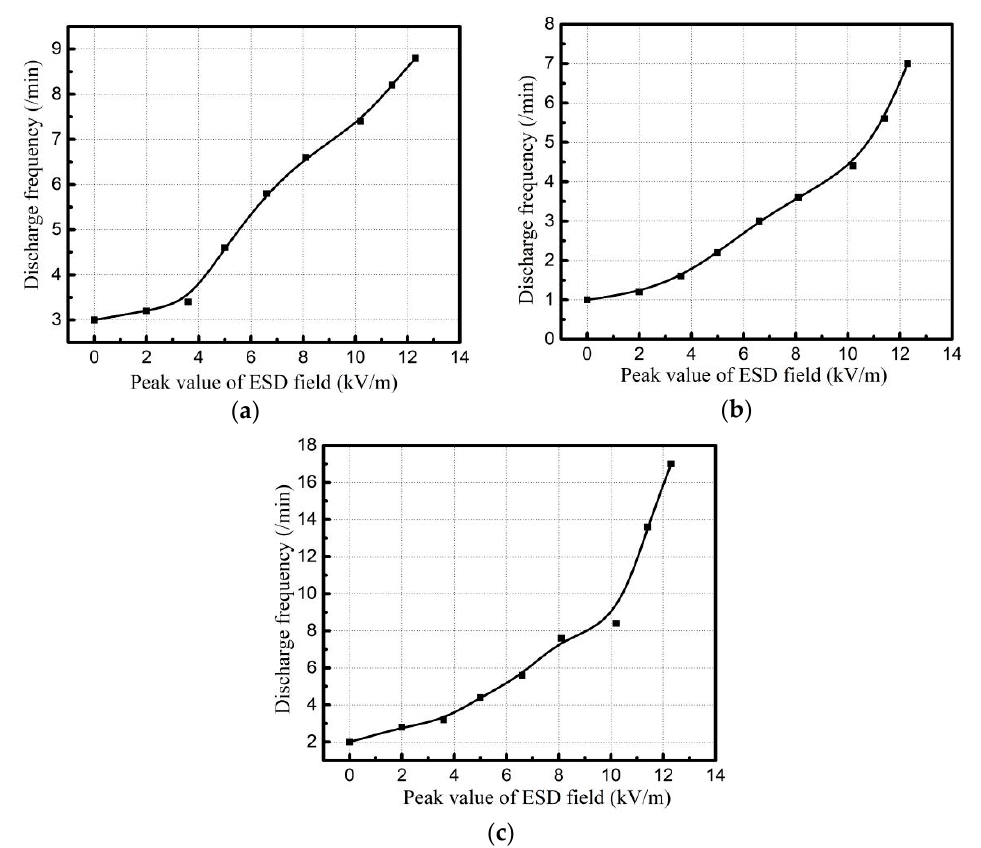
Figure 11. Variation of electrostatic discharge frequency peer minute with radiation field intensity of dielectric materials, ( a ) PI , ( b ) PTFE , ( c ) EP